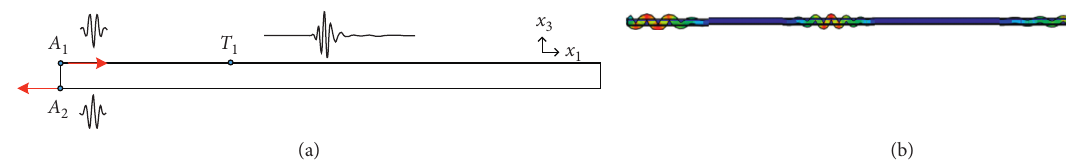
Figure 2: Simulation setup in a steel plate. (a) ABAQUS model. (b) Displacement gram in the thickness direction.